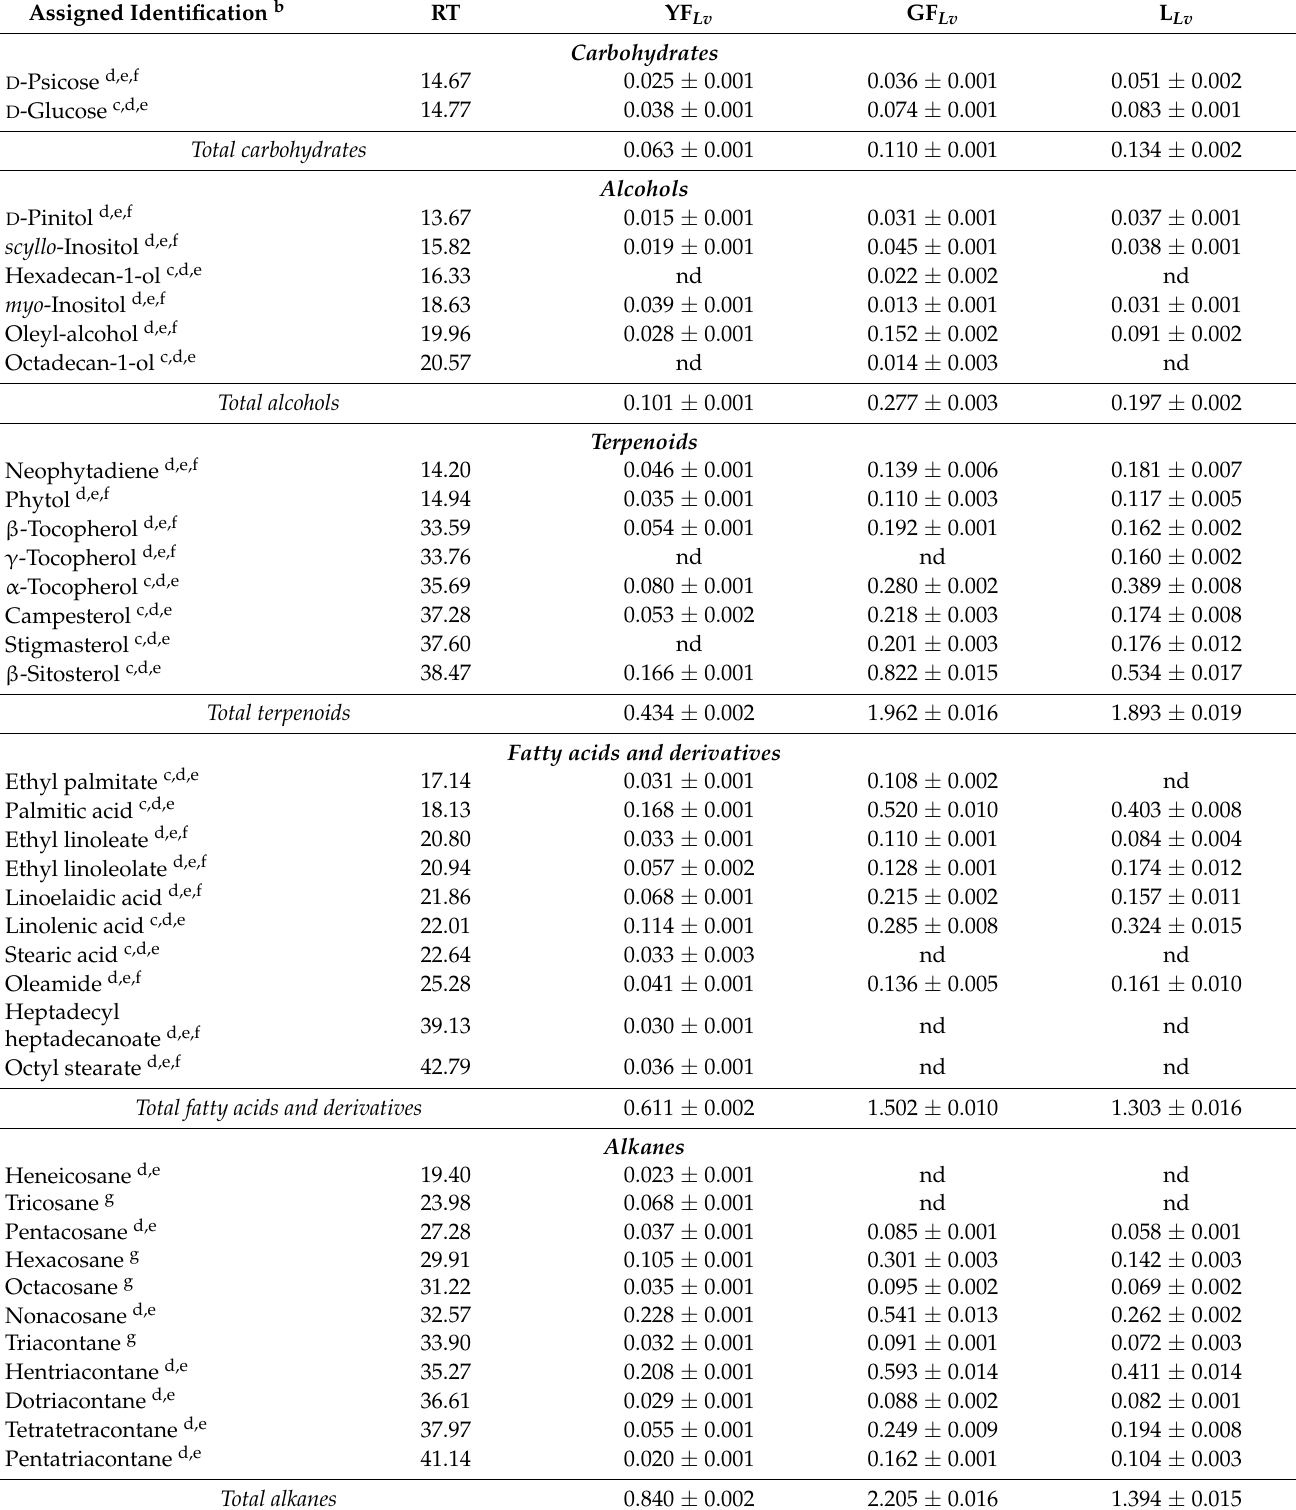
Table 1. Chemical composition of hexane extracts of L. vulgare aerial parts (mg g − 1 ± SD a